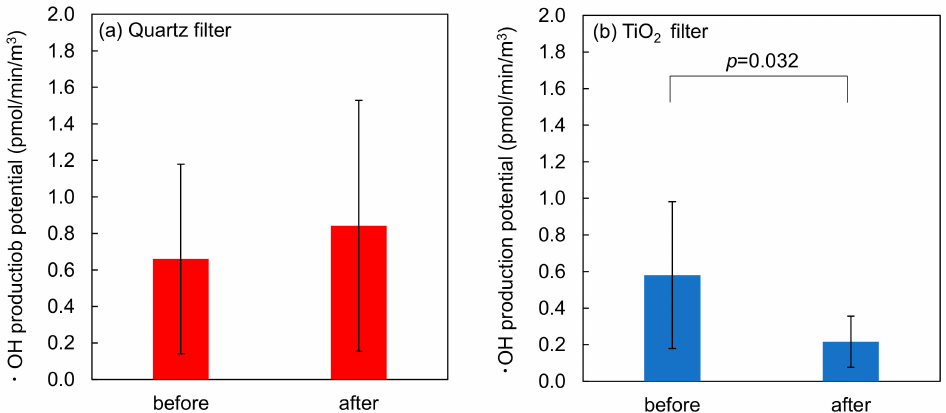
Figure 7. Comparison of the · OH production potential of PM 2.5 collected on the ( a ) quartz and ( b ) TiO 2 filters before and after UV irradiation (paired t